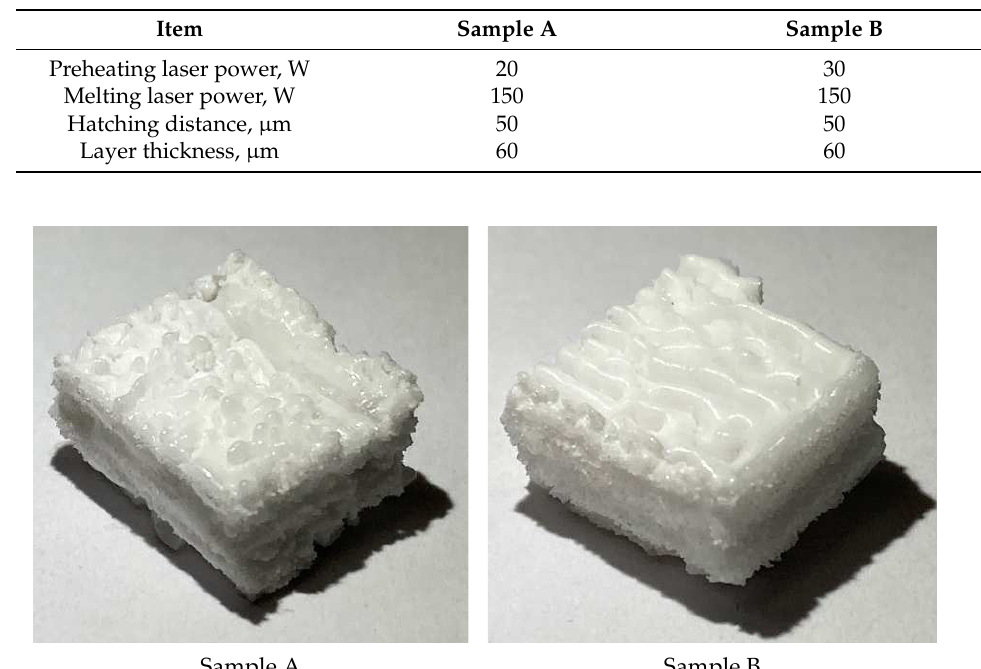
Figure 12. Alumina samples (10 × 10 × 6 mm 3 ) printed using the parameters summarised in Table 5 with 20 W preheating laser power (Sample A) and 30 W (Sample B), The Archimedes method was used to evaluate the relative density of the samples.